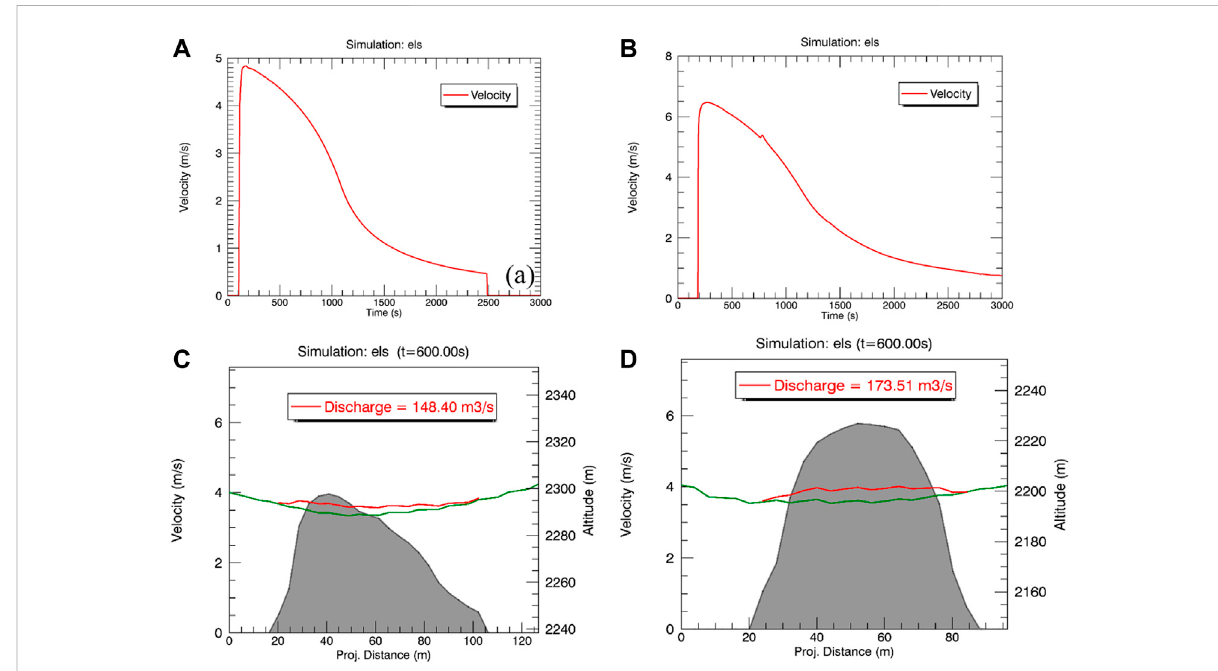
FIGURE 6 Comparison of velocity and fl owat point A and point C of thedebris fl ow on the slope surfaceat 600 s. Flow velocity at 600 sat point (A) A and (B) (C) . Discharge of (C) A section and (D) C